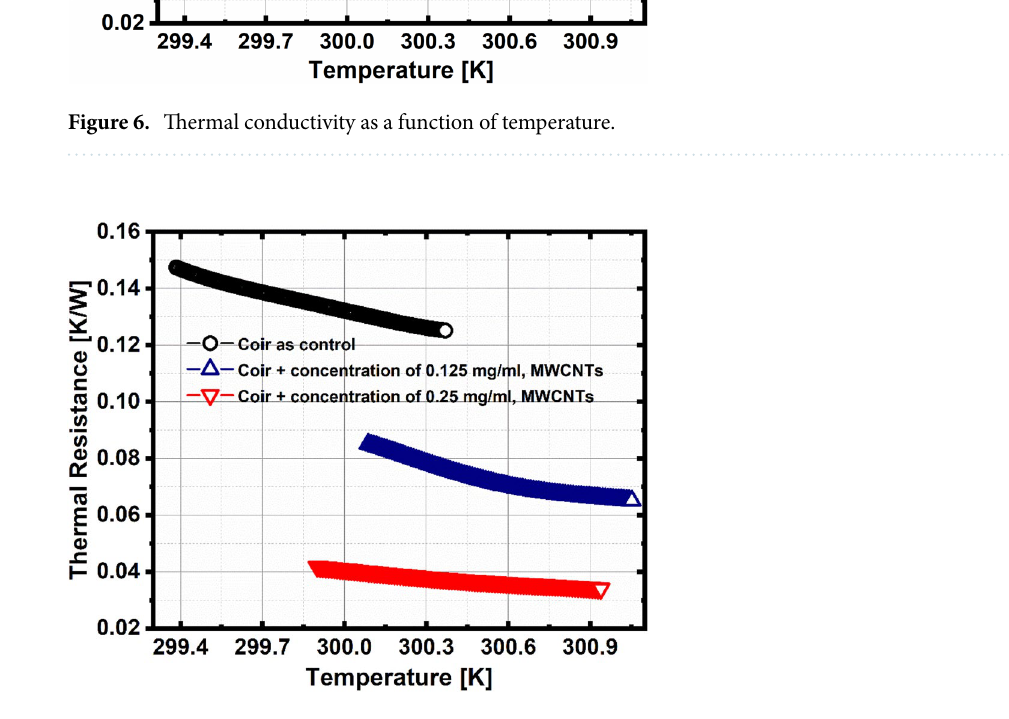
Figure 7. Thermal resistance as a function of